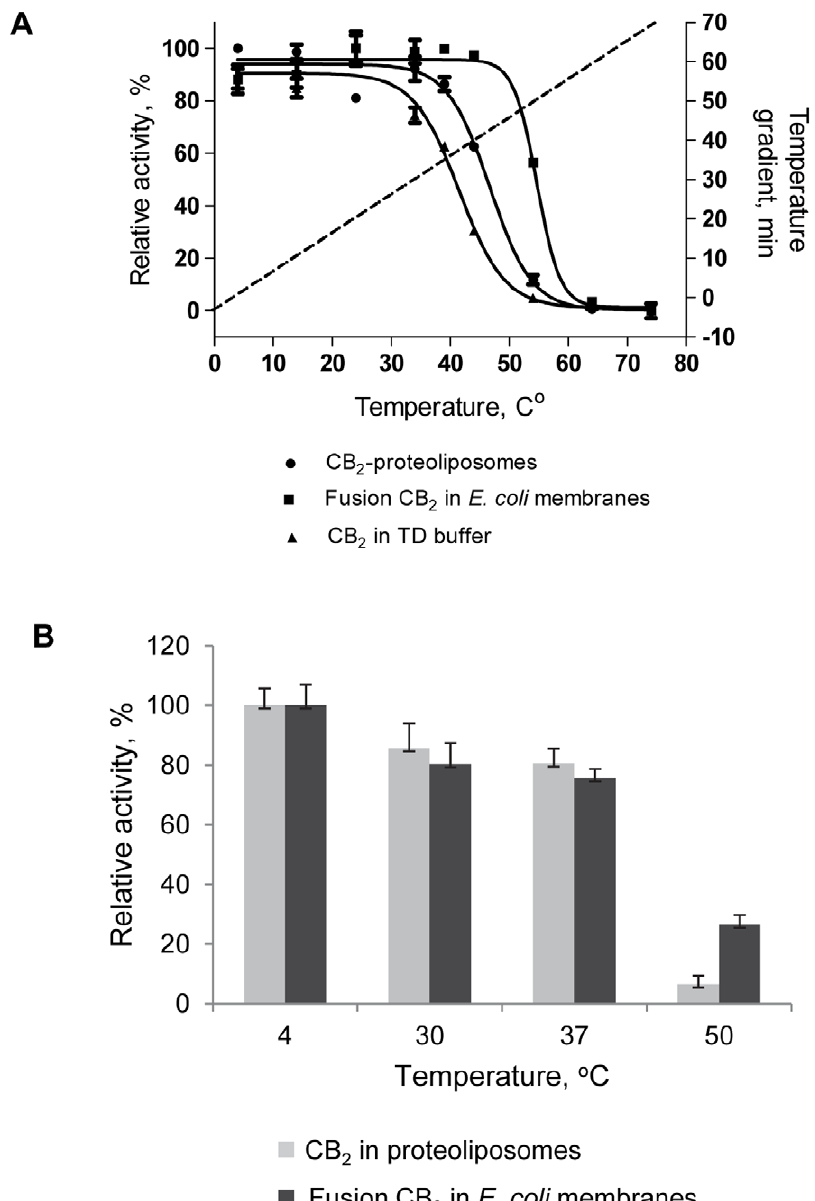
Figure 11. Stability of CB 2 in lipid bilayers. A, Temperature-induced unfolding of CB 2 in detergent micelles and lipid bilayers. For stability studies in micelles the purified CB 2 -130 in TD buffer supplemented with 10 m M CP-55,940 was subjected to a temperature gradient from 4 u C to 74 u C at a rate of 1 u C/min, 10 m g protein samples withdrawn at indicated time points, mixed with 100 m g lipids POPC/POPS (4:1 w/w) in 1% CHAPS and diluted 110-fold into cold 10 mM MOPS buffer under vigorous stirring. The activity of CB 2 was analyzed by measuring the G protein activation rates as described in Materials and Methods. For measurement of thermostability in lipid bilayers either CB 2 -proteoliposomes or membrane preparations harboring fusion CB 2 -130 were suspended in 10 mM MOPS buffer at a concentration of CB 2 0.5 ng/ m L, subjected to treatment with linear temperature gradient, and analyzed by G protein activation assay. Dotted line depicts the temperature gradient profile. Figure depicts data 6 S.D (error bars) of duplicate measurements from representative experiments (n=3). B, Temperature stability of CB 2 in proteoliposomes and E. coli membranes. Either purified CB 2 receptor reconstituted into POPC:POPS:CHS bilayers or fusion CB 2 -130 in E. coli membranes was incubated for 30 min at the temperatures indicated, and the G protein activation assay performed. 4 ng of CB 2 was used in every reaction and measurements were performed upon addition of 2 m M of CP-55,940 to all samples. Data 6 S.D. (error bars) of duplicate measurements from representative experiments (n=3) are